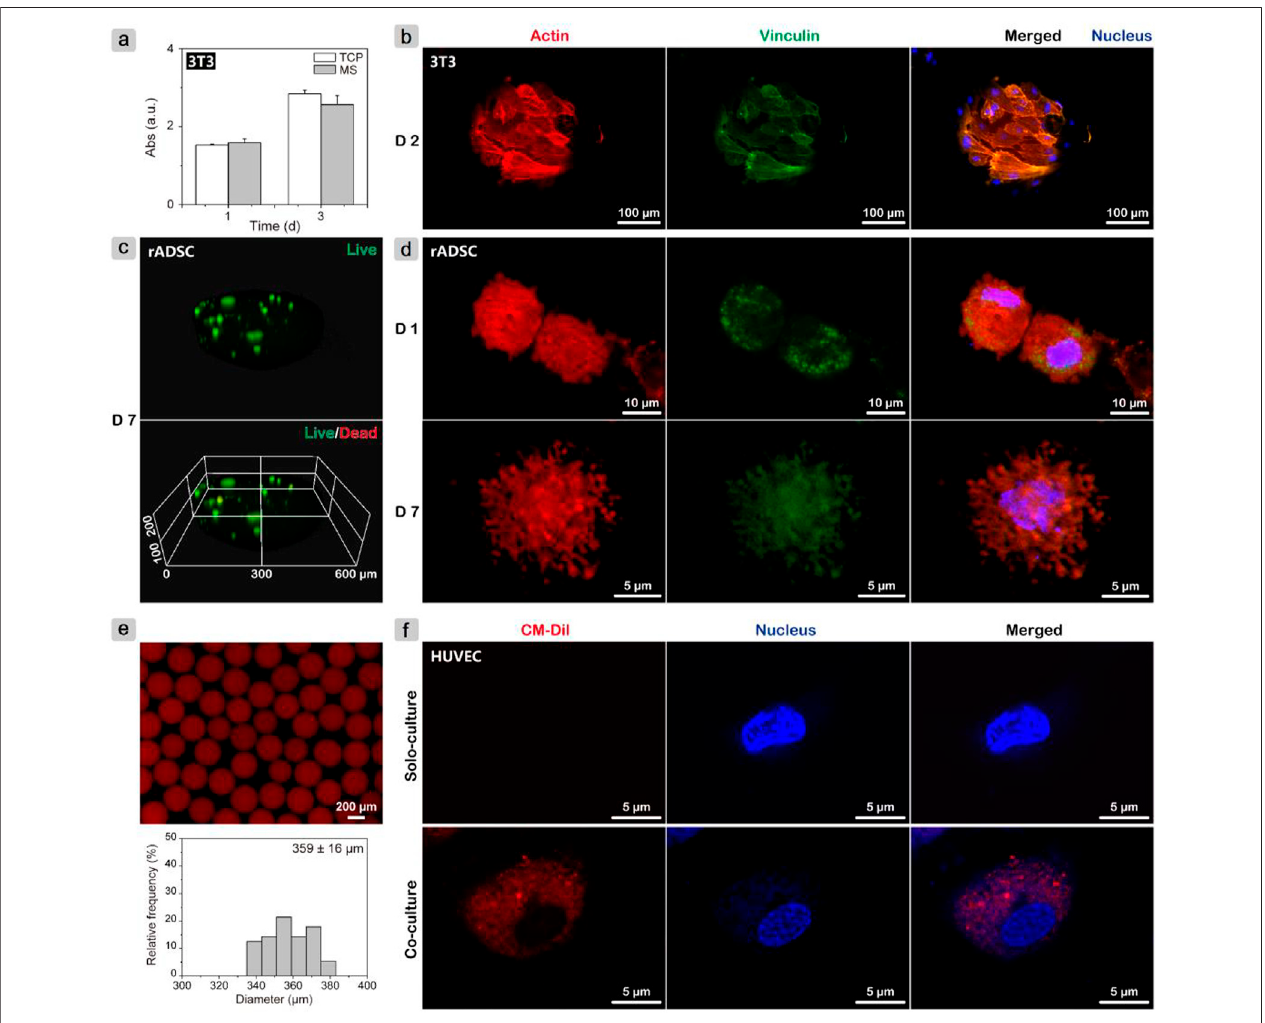
FIGURE 2 | In vitro cell test results. (A) Monitoring proliferation of NIH-3T3 cells on gelatin microspheres using CCK-8 assay; (B) CLSM images of NIH-3T3 cells after growing on microspheres for 2 days and cytoskeleton staining to evaluate adhesion behavior. (C) Live/dead assay and (D) cytoskeleton staining of rADSCs inside gelatin microspheres after culturing for 7 days to investigate cell viability and spreading morphology, respectively. (E) Fluorescence image of CM-Dil-labeled rADSC/MS and corresponding particle size distribution. (F) CLSM images of HUVECs after cocultured with CM-Dil-labeled rADSC/MS and solo-cultured for 5 days.